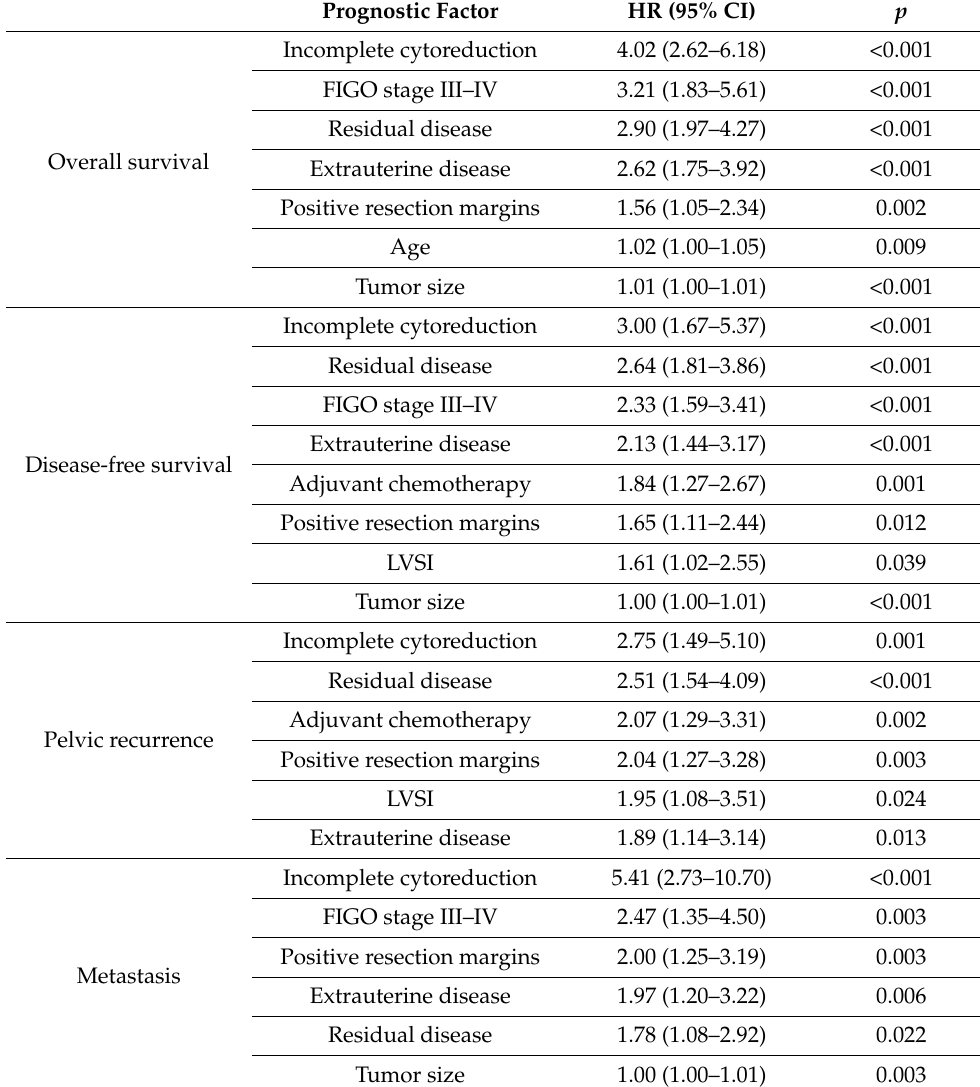
Table 2. Multivariate analysis of independent prognostic factors related to overall survival, disease- free survival, pelvic relapse, and metastatic relapse in patients with carcinosarcoma (HR: hazard ratio; CI: confidence interval; LVSI: lymph vascular space invasion; residual disease: tumor persistence after any